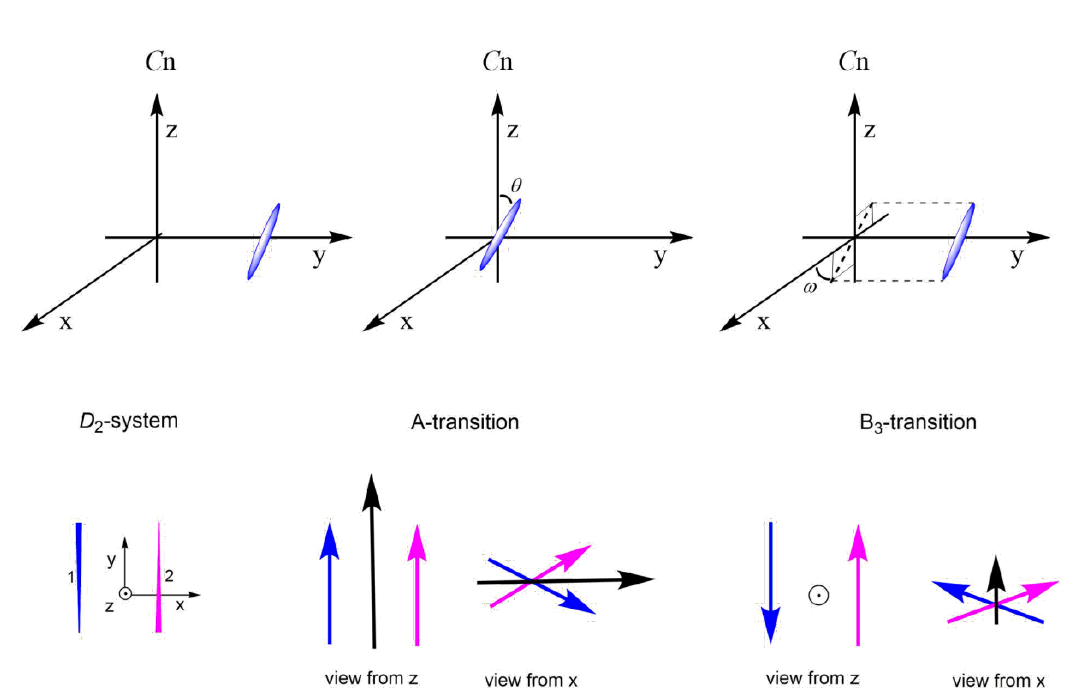
Scheme 4. Top : Representation of angles to define the position of the chromophores. Bottom : Representation of a system presenting D 2 symmetry. According to the selection rules, the two equivalent chromophores 1 (blue) and 2 (magenta) can undergo a simultaneous excitation following A or B 3 symmetry leading to total EDTMs (black) parallel to y or z, respectively, as a result of the summation of the EDTM of each chromophore. A circle with a dot in the middle represents an arrow perpendicular to the plane pointing to the reader.